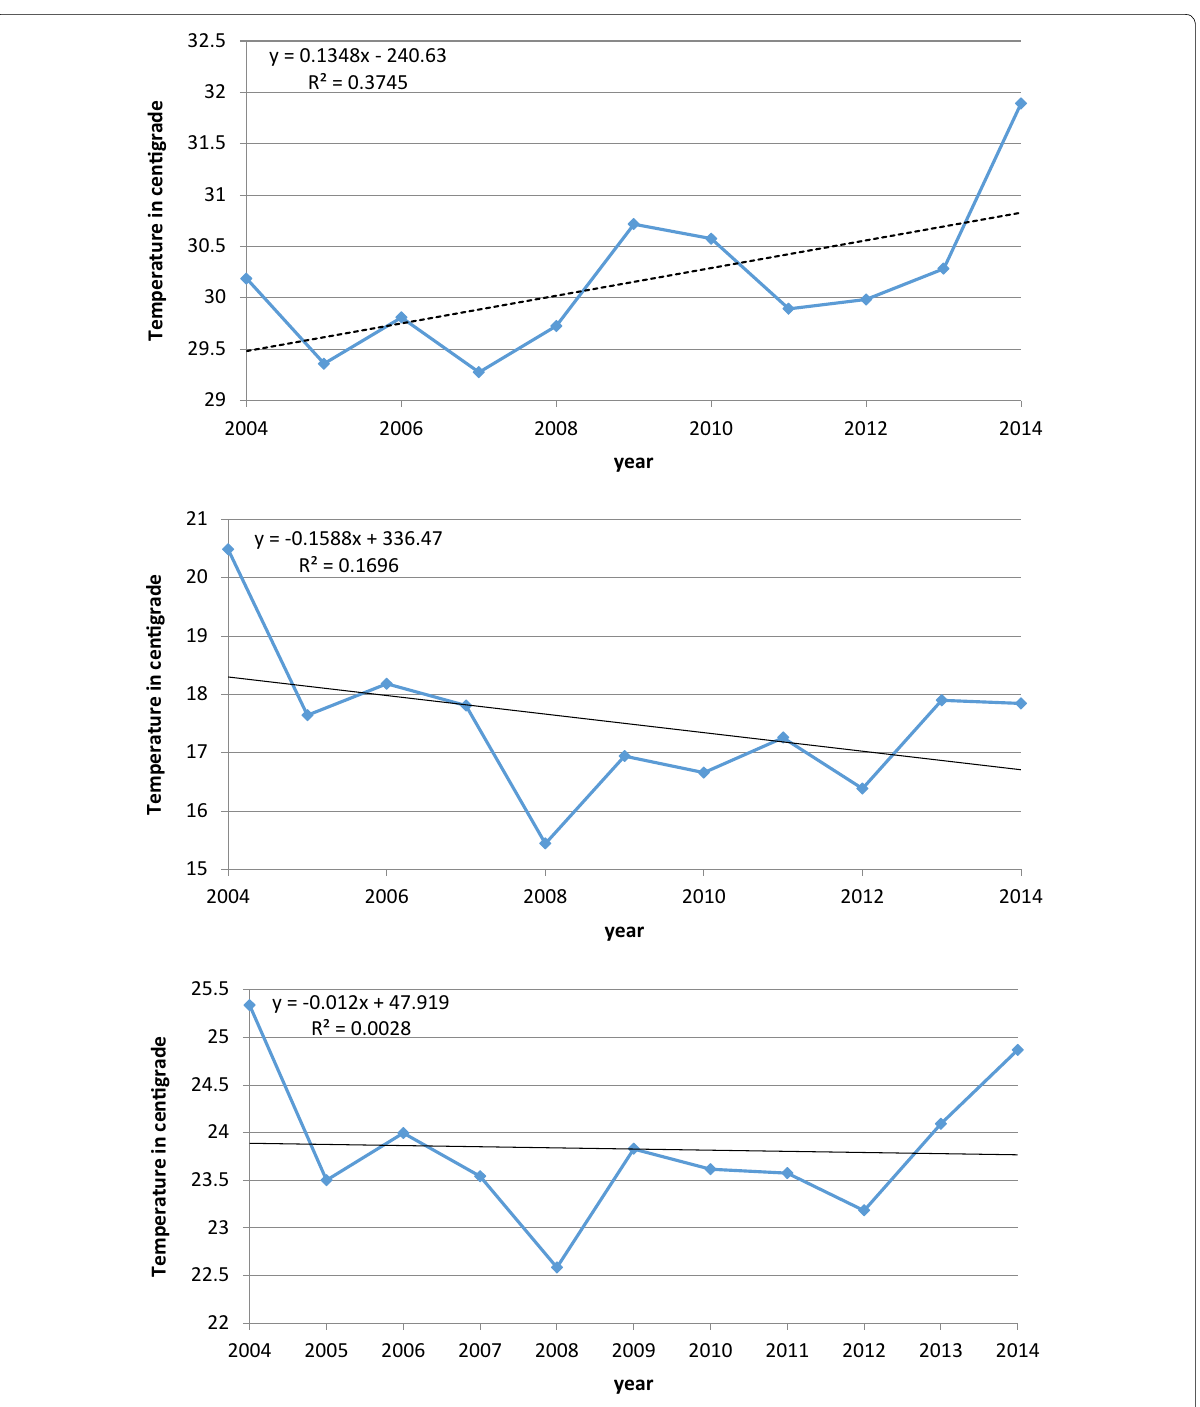
Fig. 16 11 years’ maximum, minimum and mean temperature trend for Damauli